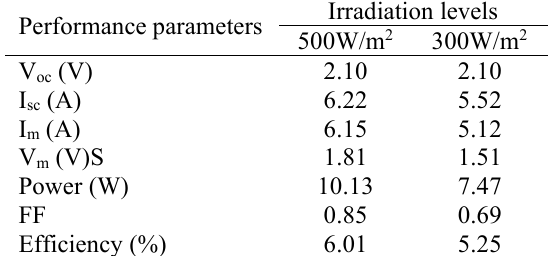
Figure 5. I-V and P-V characteristics of clean module with reflector Table 2. Electrical performance parameters of clean PV module with reflector